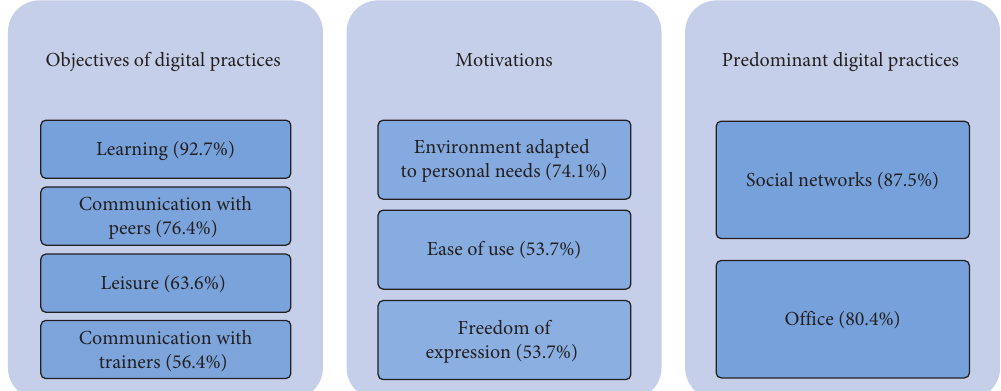
Figure 5: Predominant digital practices among prospective teachers, seen as a result of their goals and